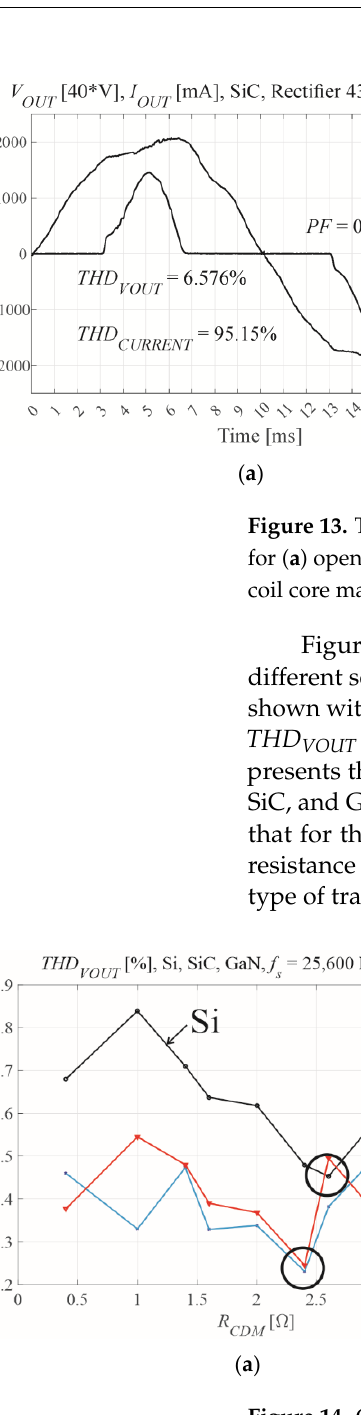
Figure 14. Graphs of THD VOUT for the different R CDM values at f s = 25,600 Hz for the Si, SiC, and GaN transistors with ( a ) Super MSS and ( b ) FluxSan coil cores for the standard rectifier RC load. Black circles highlight the THD VOUT minima. Table 2. THD minima for each R CDM , transistor type, and coil core material.